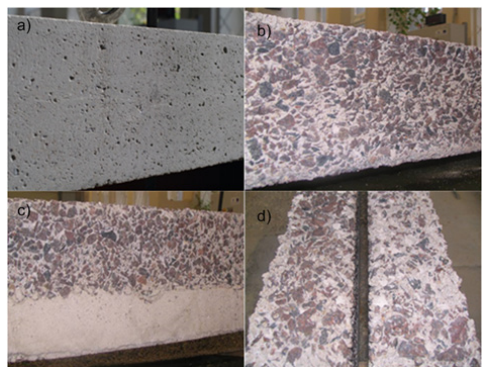
Fig. 2. Surfaces after treatment: (a) not suitable surface after treatment with steel brushes; (b) surface for beams SxU after treatment with high-pressure water jet; (c) and (d) surfaces of beams SxT All beams were reinforced with the same carcass made from the same steel bars. A reinforcement scheme is presented in Figure 3. Ribbed steel bars were used for longitudinal and shear reinforcement. The latter one was used only in the parts where shear forces were exerted. At the middle part of the beam, shear reinforcement was not used because only major stresses acted in the pure bending zone.